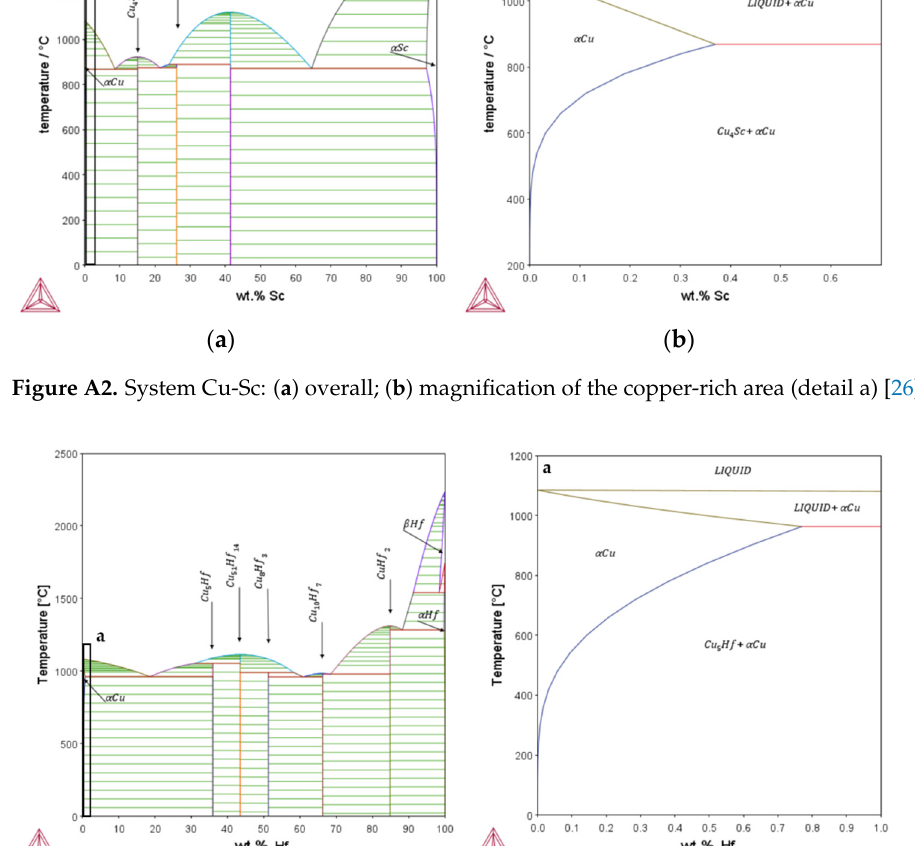
Figure A3. System Cu-Hf: ( a ) overall; ( b ) magnification of the copper-rich area (detail a).